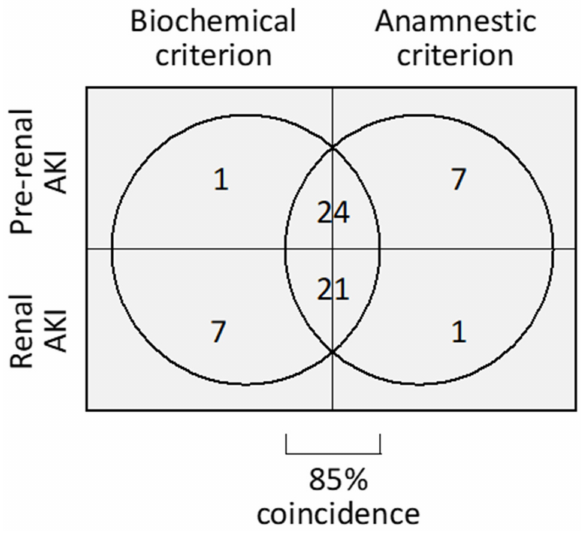
Figure 1. Distribution of pre-renal and renal AKI patients according to the biochemical and anamnes- tic criteria. Table 1. Patient characteristics per AKI type (i.e., pre-renal or renal) according to anamnestic and biochemical criteria. Data are presented as the median (minimum–maximum). ACEIs, angiotensin- converting enzyme inhibitors; AKI, acute kidney injury. ARBs, angiotensin II receptor blockers; NSAIDs, non-steroidal anti-inflammatory